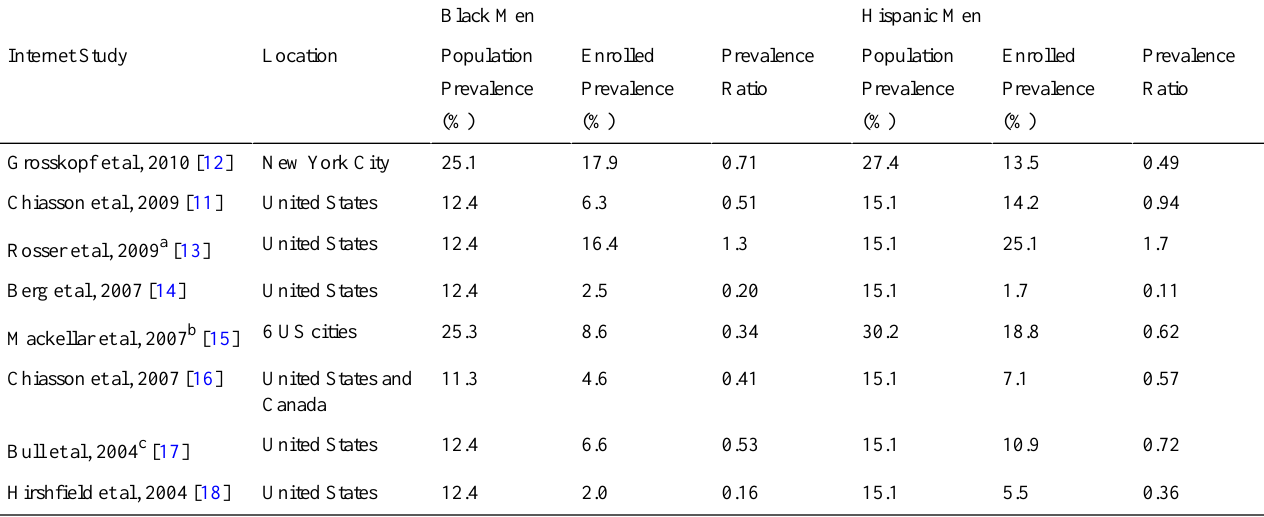
Table 1. Selected Internet-based HIV prevention studies of men who have sex with men depicting population prevalence from recruitment location, enrolled study population prevalence, and corresponding prevalence ratio of black and Hispanic